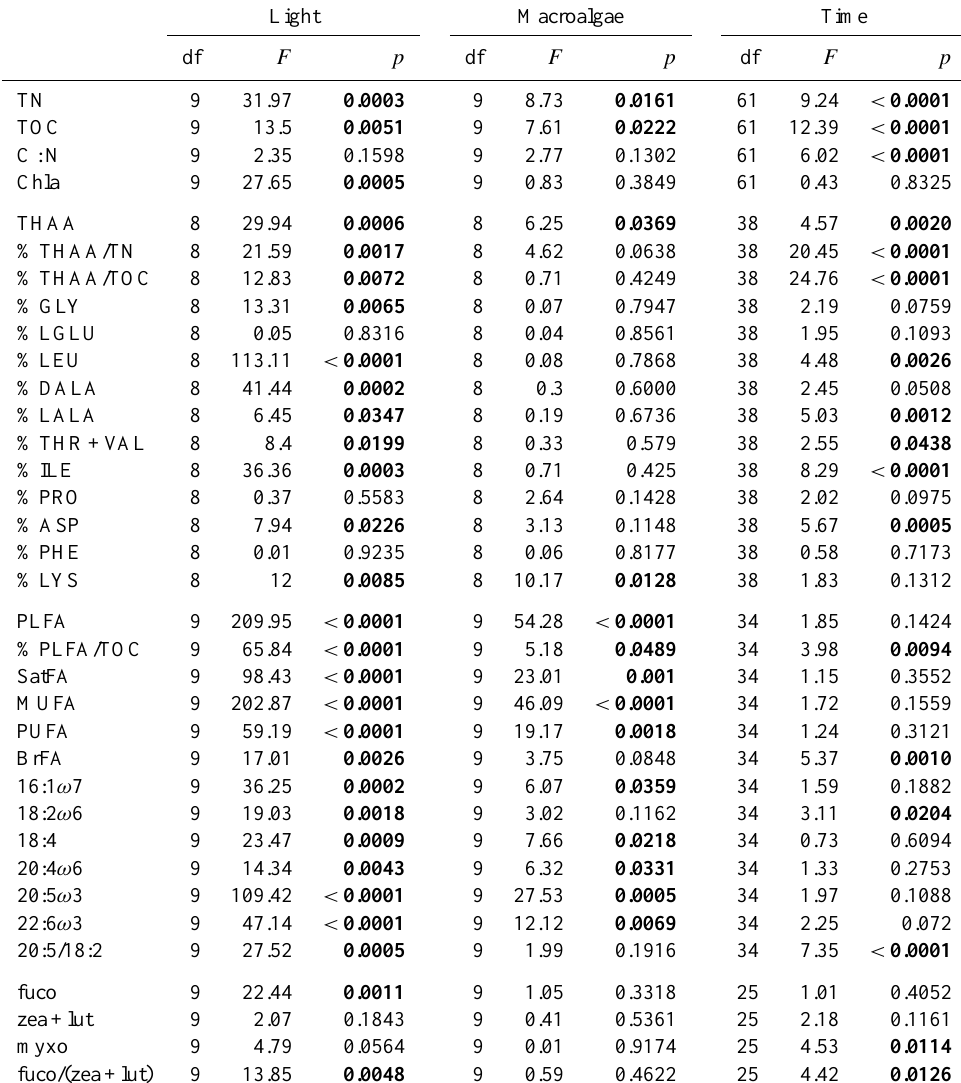
Table 3. Results of two-factor repeated measures ANOVA, which was used to test for differences in light and macroalgae over time for various sediment organic matter variables. Significant p values ( < 0.05) are indicated in